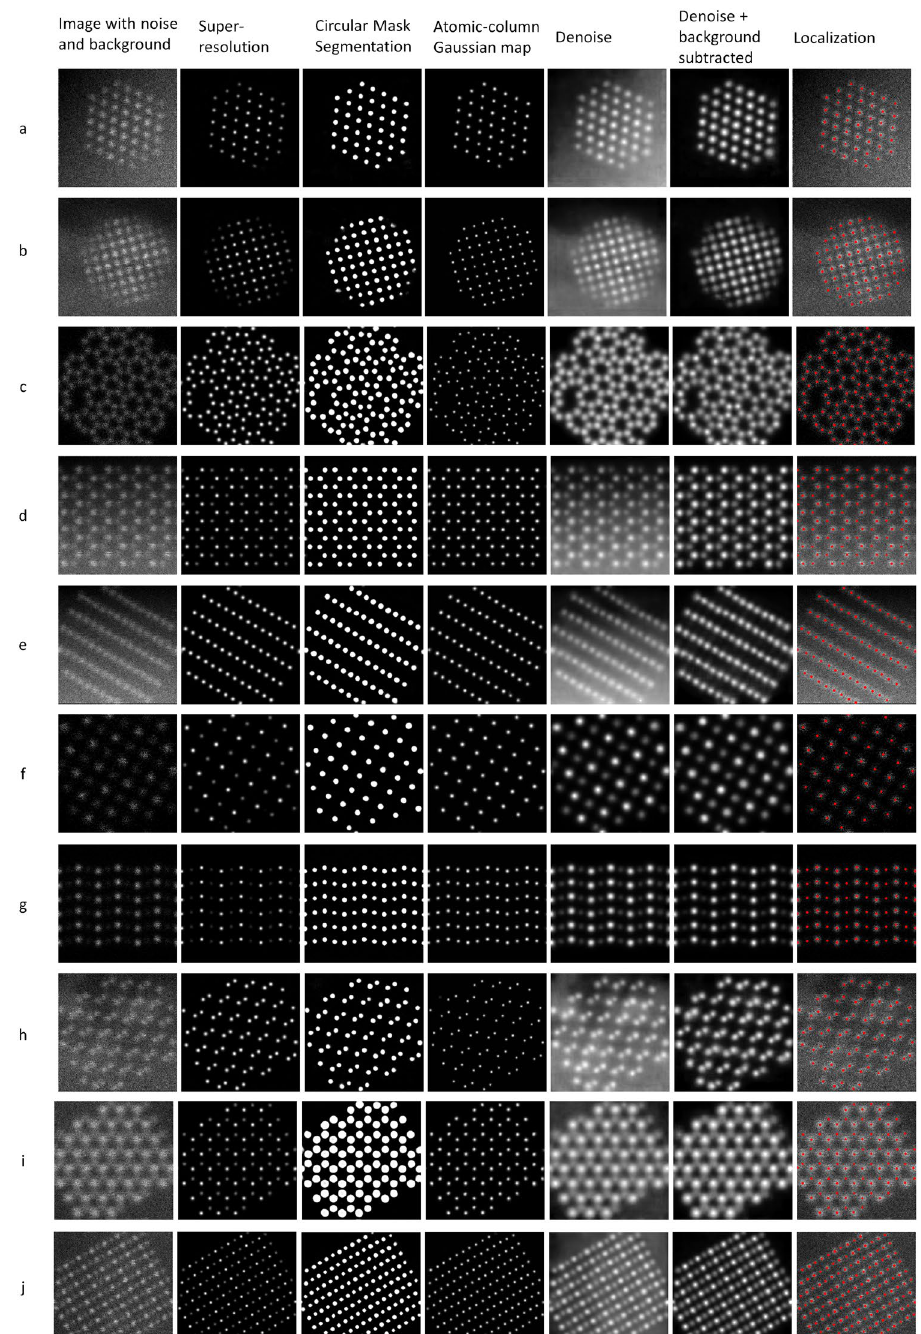
Figure 5. Model validation using the validation set of TEMImageNet. The peak signal-to-noise ratio of images ( a – j ) are around 20 db (or 10 in linear